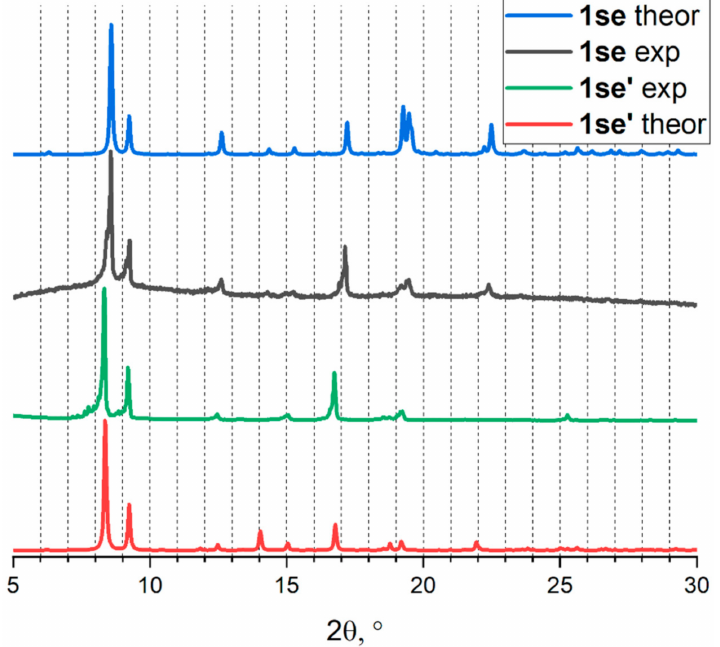
Figure 2. PXRDpatternsofthetheoreticallysimulated 1se (blue), as-synthesized 1se (black), activated 1se (cid:48)